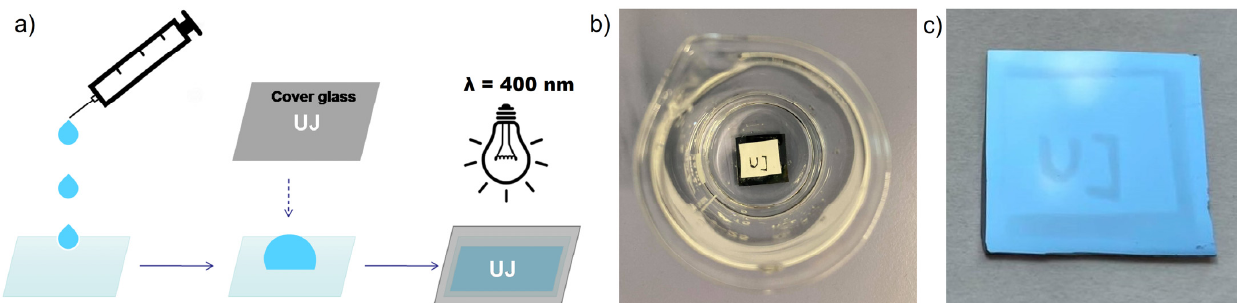
Figure 10. AFM images with corresponding cross-section profiles of patterned PMTM brushes synthesized by metal-free SI-ATRP by placement of the TEM grid with ( a ) shiny side faced to LED lamps and ( b ) matte side faced to LED lamps.